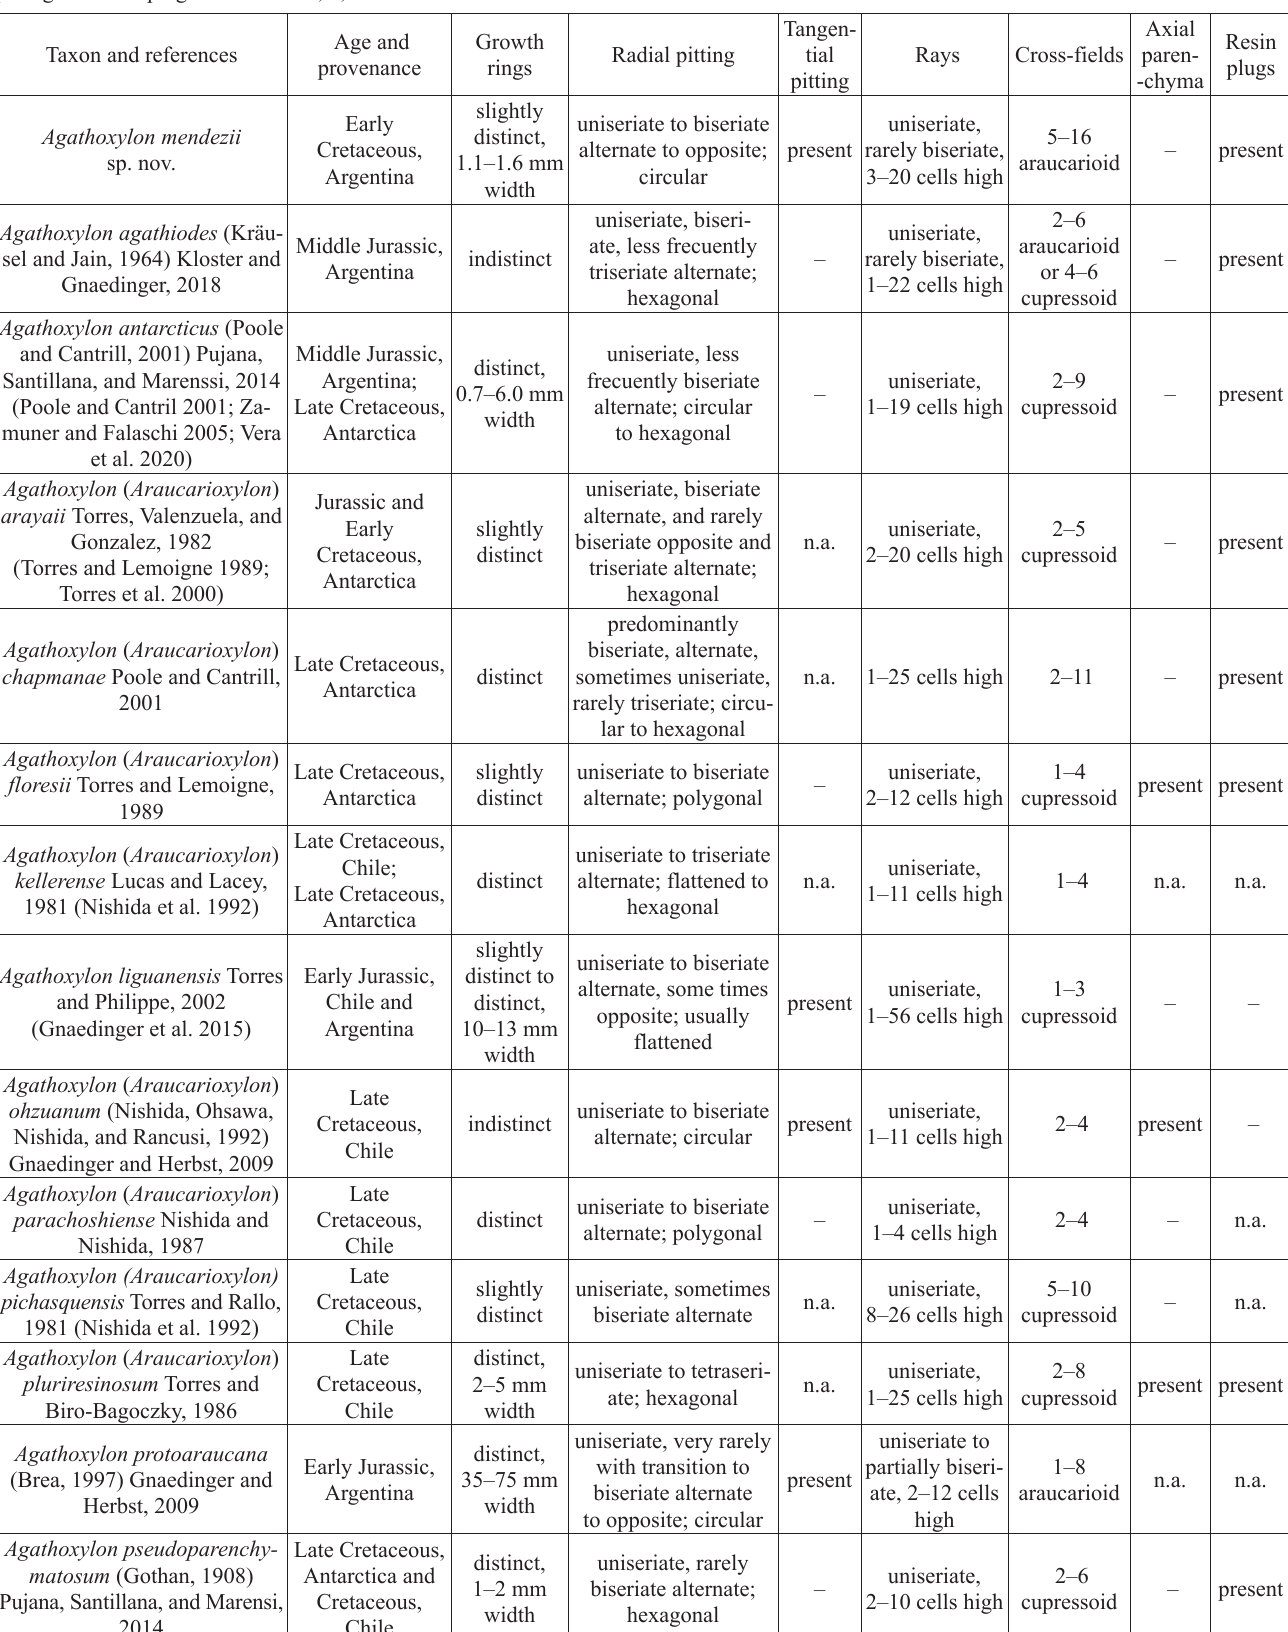
Table 1. Comparison among selected Mesozoic Agathoxylon species from Western Gondwana; n.a., data about growth ring width, tangential pitting and resin plugs not available; –,